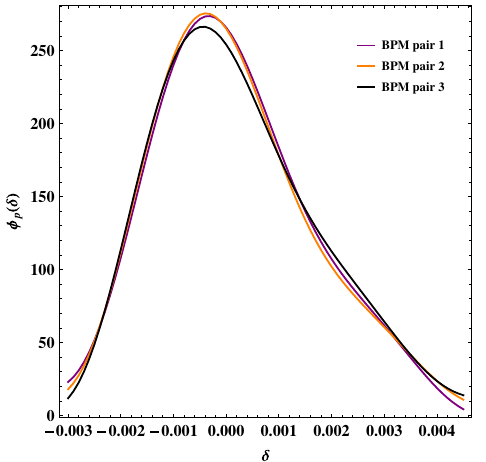
FIG. 9. Reconstruction of the momentum distribution